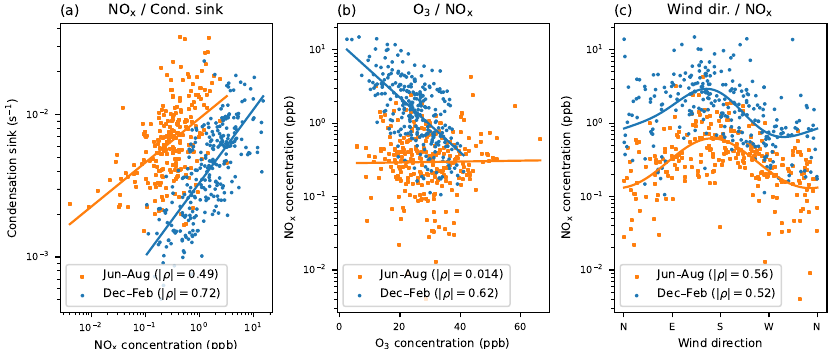
Figure 8. Examples of non-linear correlations related to trace gases and condensation sink. Observa- tions are separated by season, but a random sample from all times of day is used. The correlation coefficient ρ refers to each fitted non-linear model. ( a ) Condensation sink and concentration of nitrous oxides are both logarithmic variables. A log-log-linear model explains their correlation. Conditional MI from Figure 7b is 0.62. ( b ) Ozone follows a linear scale. The log-linear correlation between O 3 and NO x depends heavily on the season. Conditional MI is 0.48. ( c ) Wind direction versus logarithmic NO x concentration. A two-level trigonometric model analogous to Equation (5) is fitted. Conditional MI is 0.58. Existing literature suggests that wind direction explains all three other variables